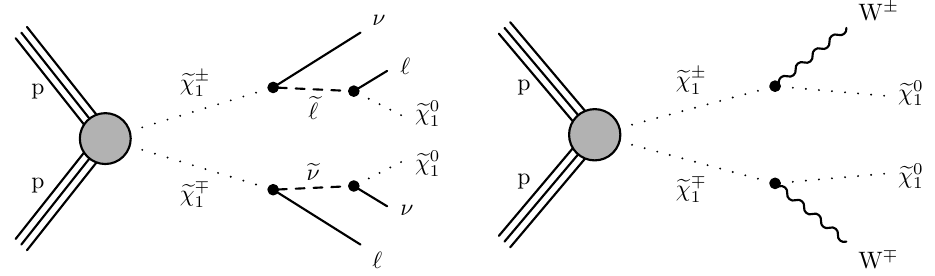
Figure 1 . Simpli(cid:12)ed-model diagrams of chargino pair production with two benchmark decay modes: the left plot shows decays through intermediate sleptons or sneutrinos, while the right one displays prompt decays into a W boson and the lightest